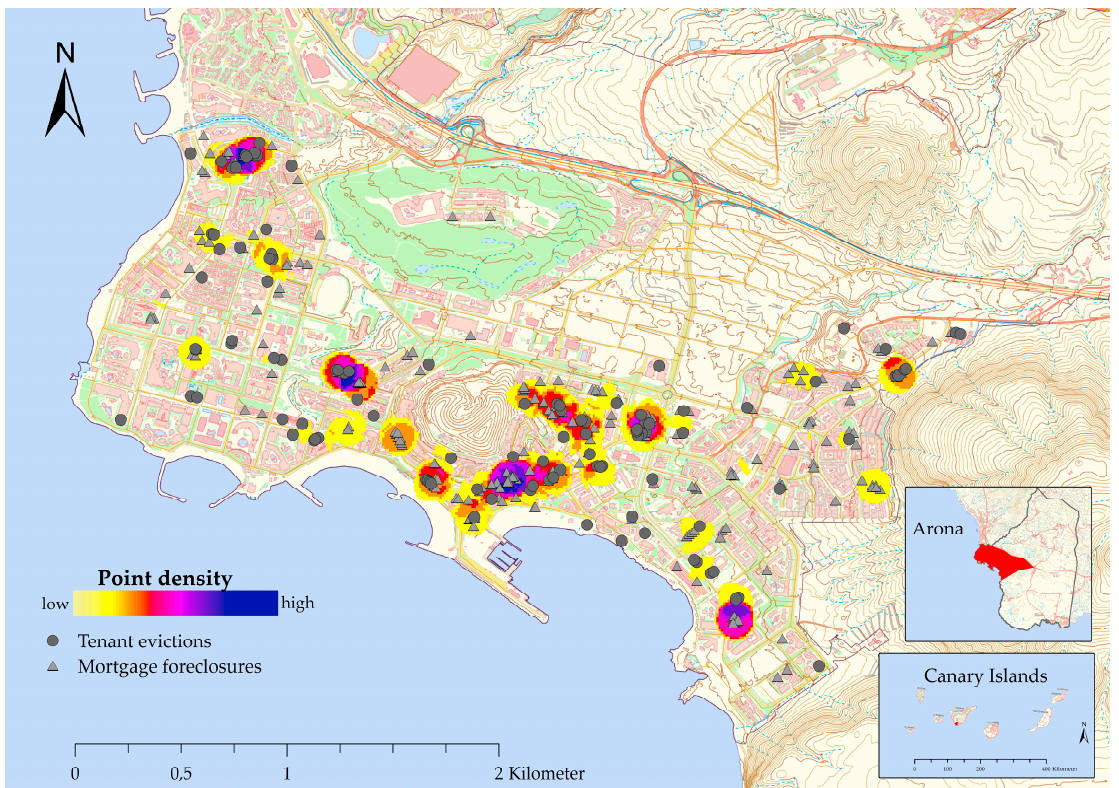
Figure 3. Density of real estate dispossession in Los Cristianos/Las Am é ricas (2001–2015). Database ATLANTE (CGPJ). Own elaboration. Mapa topogr á fico Grafcan